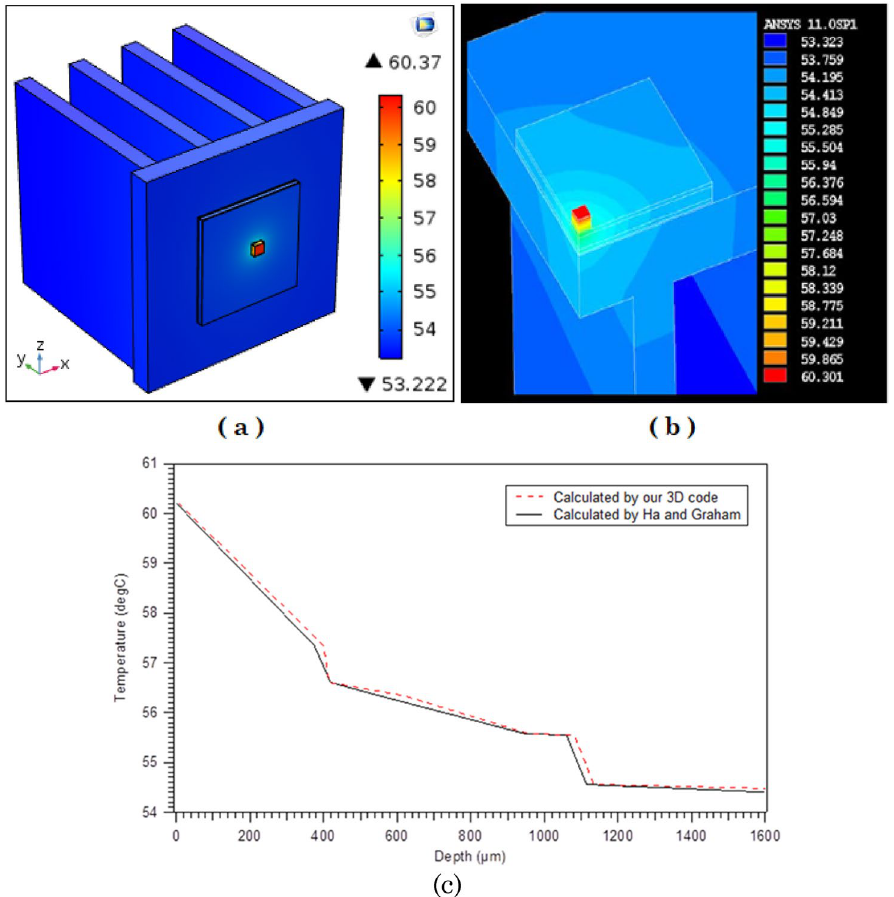
Figure 3. Temperature distribution of the LED package: ( a ): Our 3D code ( b ): Ha and Graham code 7 ( c ), Comparison of vertical temperature profile along the center line (z axis) 8 (COMSOL Multiphysics 5.6, https:// www. comsol.